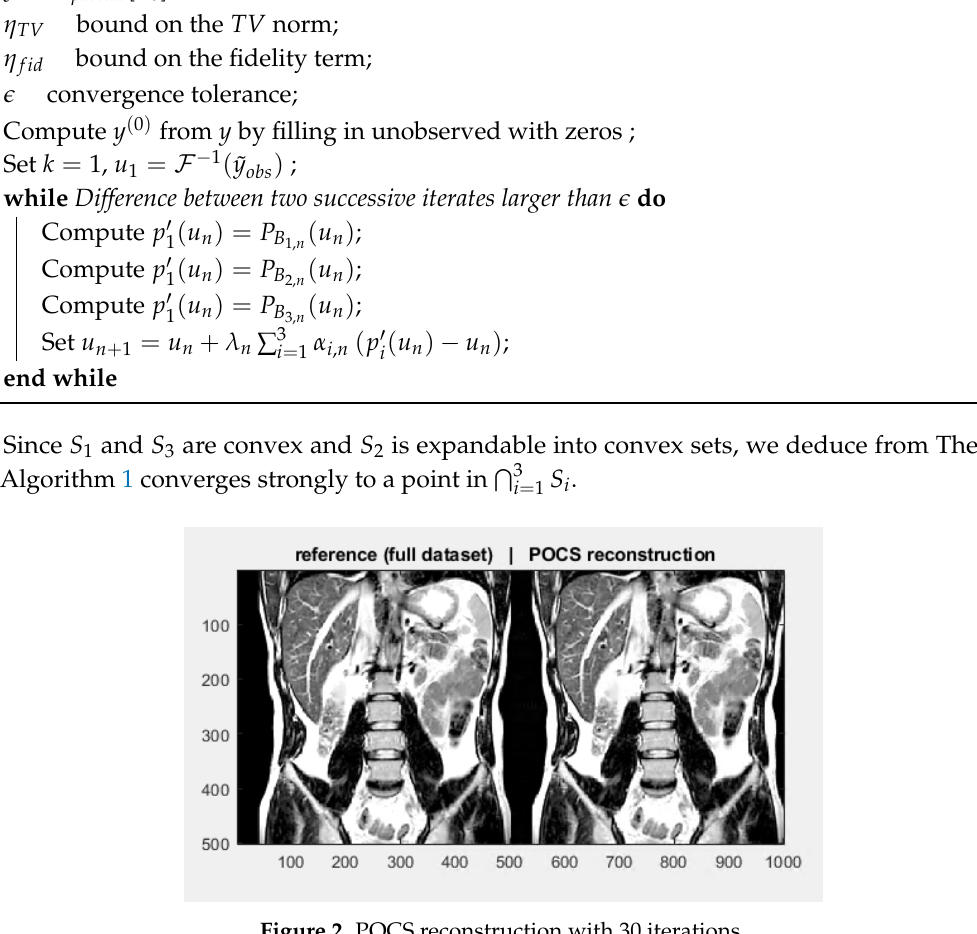
Figure 2. POCS reconstruction with 30